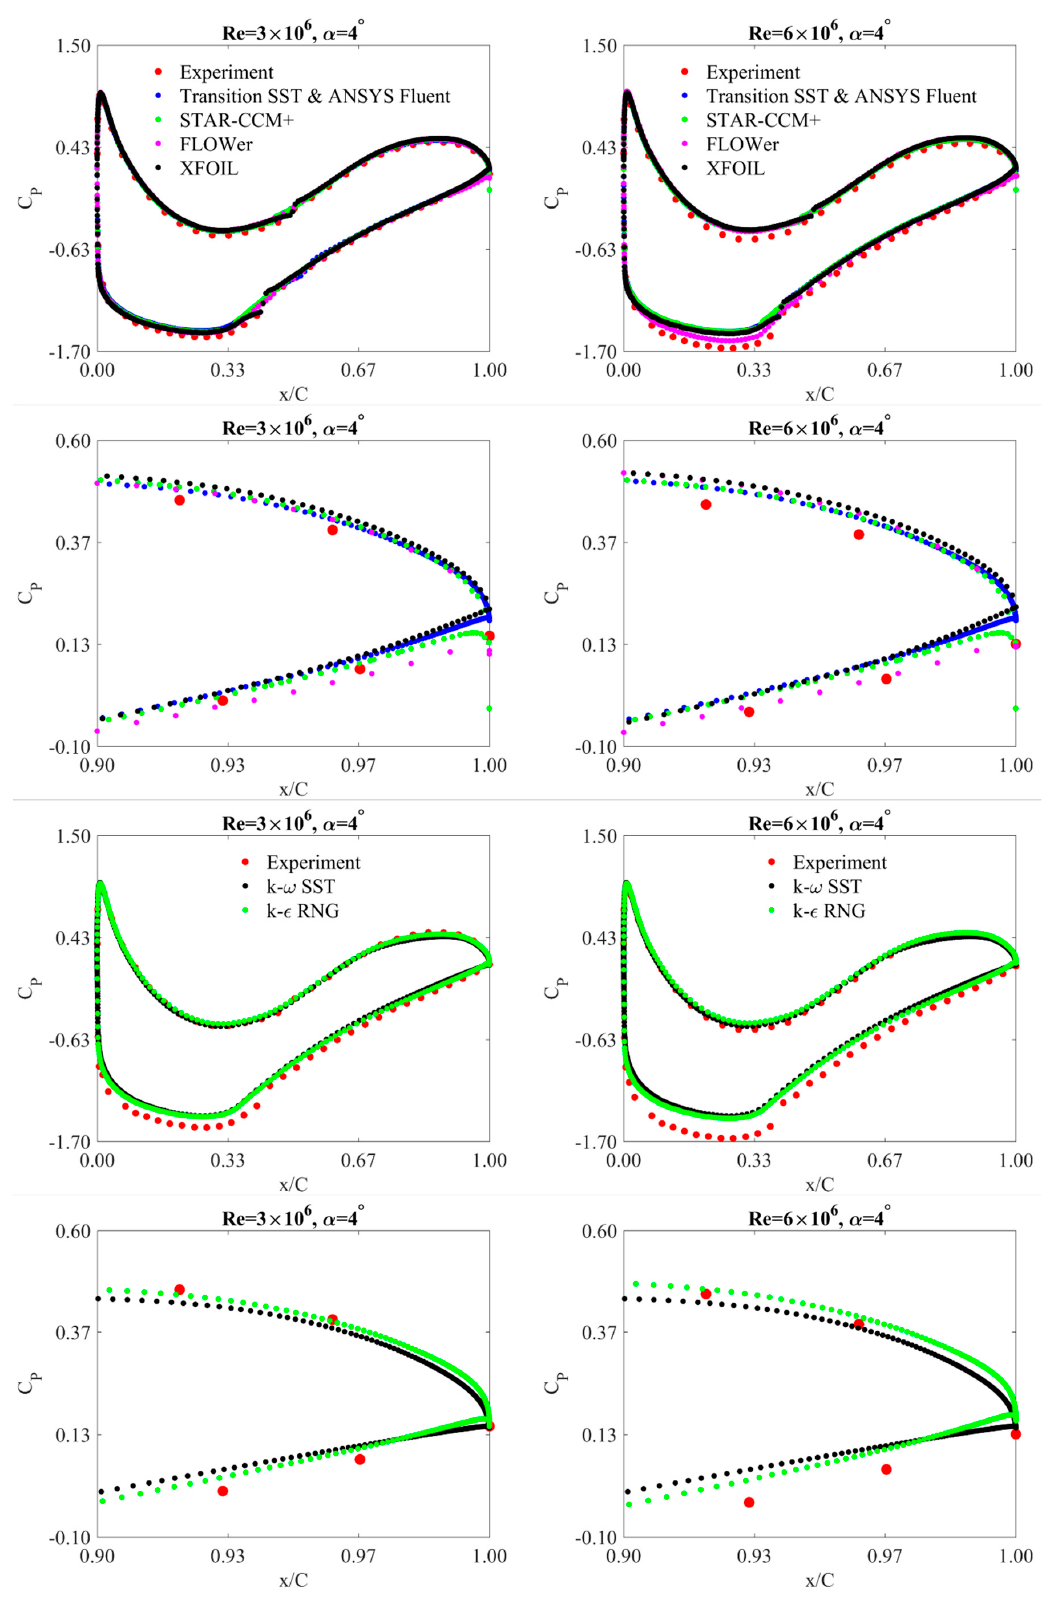
Figure 7. Static pressure distributions calculated for different numerical approaches. The results are presented for one angle of attack equal to 4 degrees.